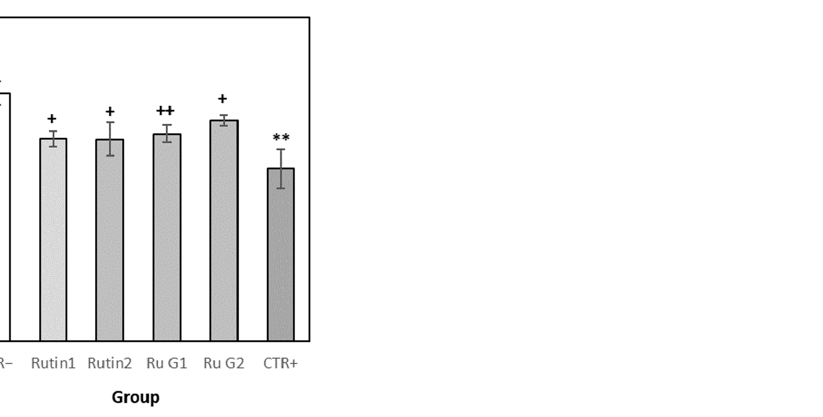
Figure 9. The aggregation rates of PRP in vivo. Each time point represented the mean ± S.E. ( n = 8). CTR − ; normal control, CTR+; positive control (aspirin), Ru G; rutin glycoside. Significant differences from the normal control group were determined via Independent t -test (** p < 0.01). Significant differences from the normal control group were determined via Dunnett’s t -test (+ p < 0.05, ++ p < 0.01). 3.7.4. Effects of Rutin and Rutin Glycoside on Blood Coagulation In Vivo In the blood coagulation test, the PT of the normal control group was 9.5 s, that of the positive control group was 14.3 s and those of the test material rutin 100 mg/kg, rutin 400 mg/kg and rutin glycoside 139 mg/kg administration group were all 9.5 s (Figure 10). Con- trary to the platelet aggregation rate, there was no significant difference in the rutin or rutin glycoside groups compared to the normal control group. The PT of the rutin glyco- side 556 mg/kg administration group was 9.8 s, slightly delayed compared to the normal control group, but this was not statistically significant. The results of APTT were similar to those of PT. The APTT of the normal control group was 19.3 s, those of the positive control group were 156.0 s and those of the test material rutin 100 mg/kg administration